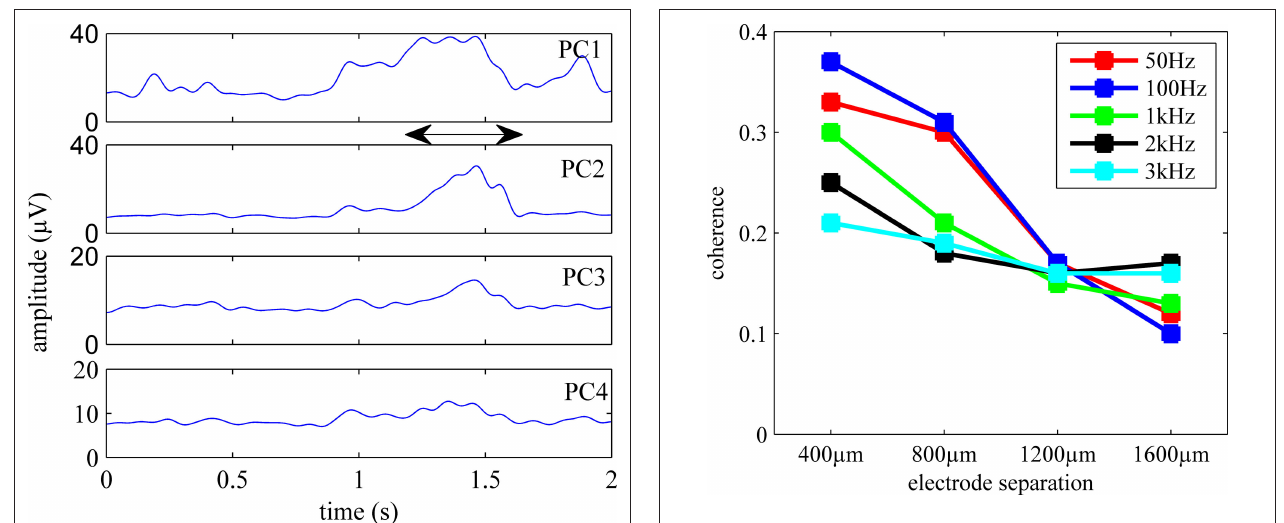
Figure 8 | Coherence at different frequencies as a function of electrode separation extracted from Figure 7. Average coherence steadily decreases by distance for the range (400–1600 μm) and frequencies